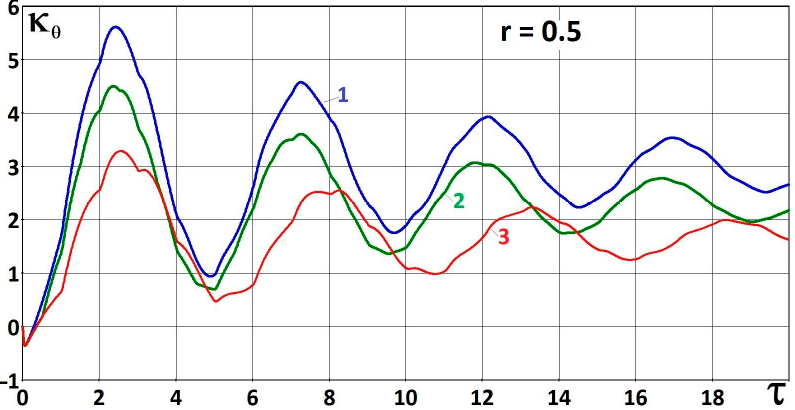
Figure 9. Time history of the relative circumferential stress at r = 0.5. Viscoelastic materials. FGM cylinder—curve 1; two-layer cylinder—curve 2; homogeneous cylinder—curve 3.